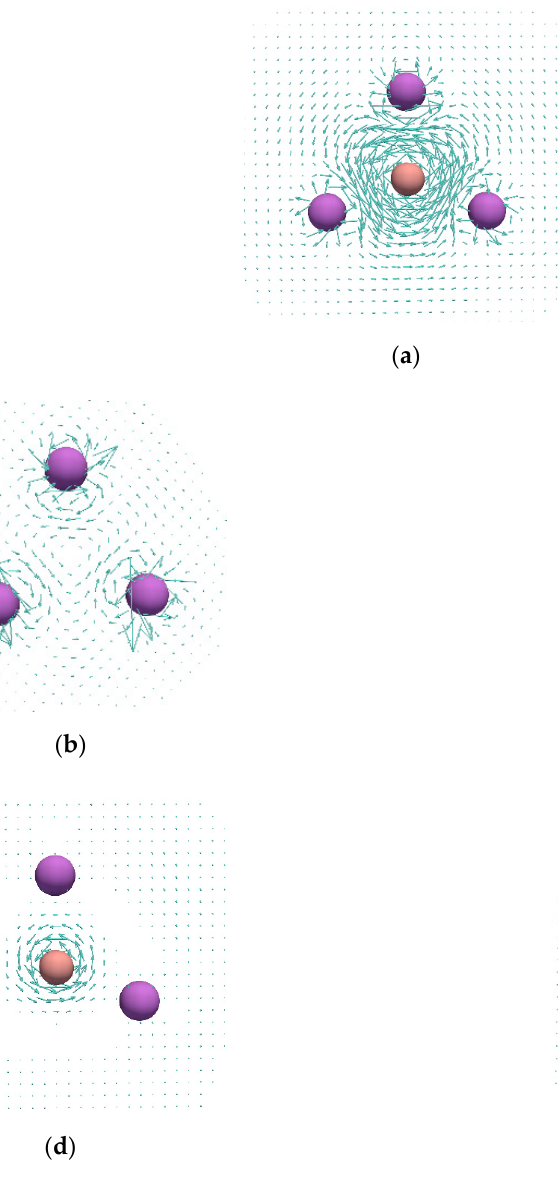
Figure 3. Current density maps calculated in the plane of the Li-atom ring: Li 3 B 2 − ( a ), Li 3 + ( b ), HOMO of Li 3 B 2 − ( d ), quasi-doubly degenerate HOMO-1 of Li 3 B 2 − ( e ); current densities plotted in the plane that perpendicularly bisects the B–B bond of the B 22 − fragment extracted from the optimized geometry of Li 3 B 2 − ( c